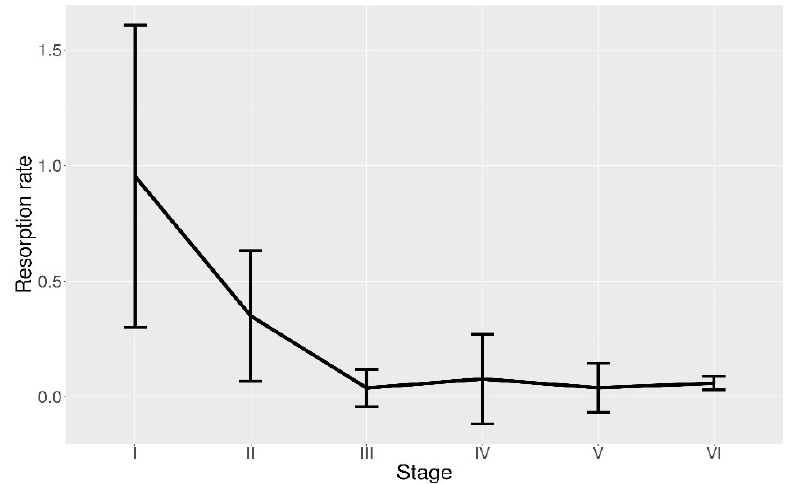
Figure 6. Mean resorption rate and relative confidence interval per each postovulatory follicle (POF) stage (I to VI), measured as area reduction along the two hour-long intervals. The hourly distributions indicated that the early stages (POFs I to POF II) disappeared in about 10 h after the ASP. Meanwhile, POFs from stage III onwards were spread along the whole day, although displaying different incidence per two hour-long intervals and clear peaks of maximum and minimum abundance. However, all the resorption stages from IV to VI assumed lower values during night and morning. For POFs IV a peak of high presence was recorded in the interval from 6:00 to 8:00, while for stages V and VI similar peaks were observed later in the evening, starting in the early afternoon (Figure 5A,B). These distributions, which displayed only POFs I to III to persist less than one day (Figure 5A,B), look similar to POF stage aging (Figure 7).